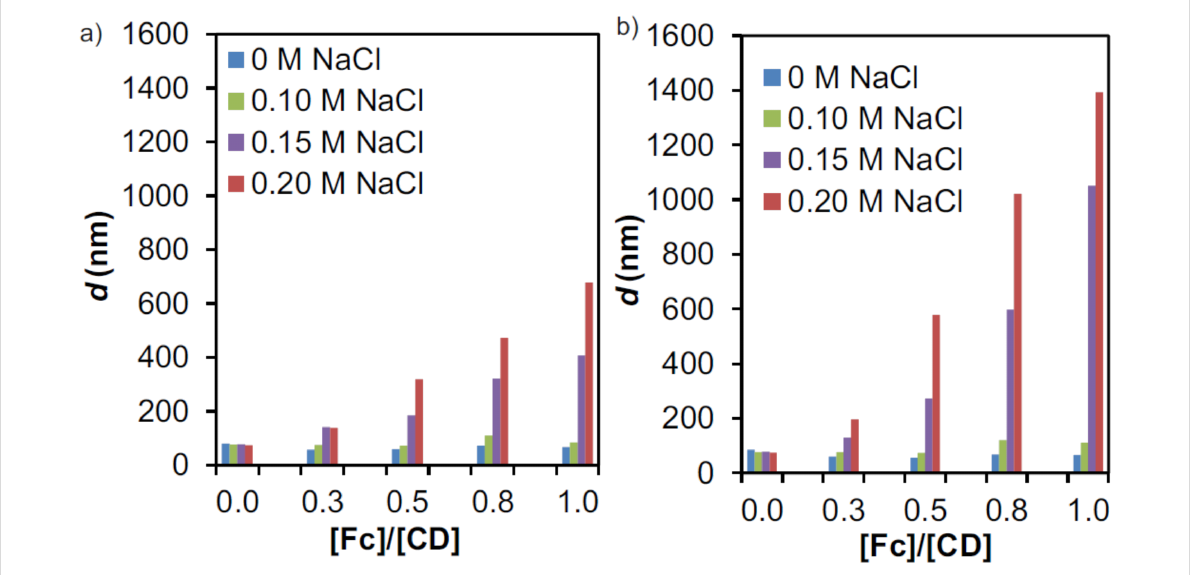
Figure 4: DLS size determination of SNPs prepared from CD-PEI and Fc 8 -PAMAM by increasing the [Fc]/[CD] ratio (in Fc and CD moieties from Fc 8 - PAMAM and CD-PEI, respectively) at different salt concentrations (0–0.2 M NaCl) keeping constant the total concentration using [CD] = 100 µM after: a) 20 min and b) 3 h.